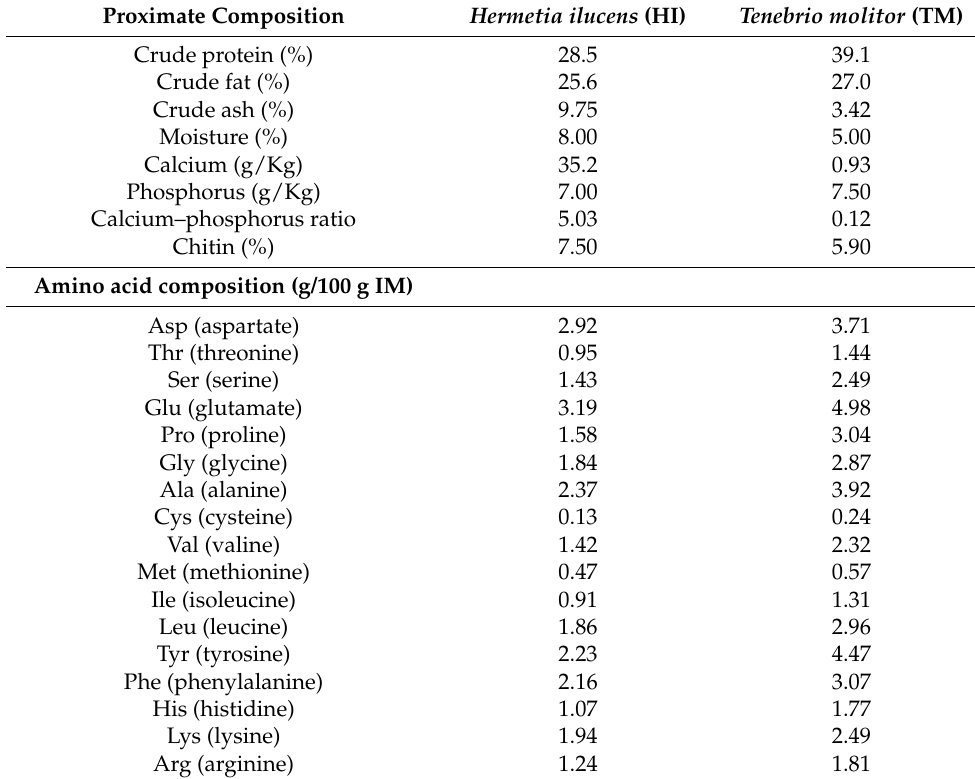
Table 1. Proximate and amino acids compositions of insect meals (IMs). Proximate